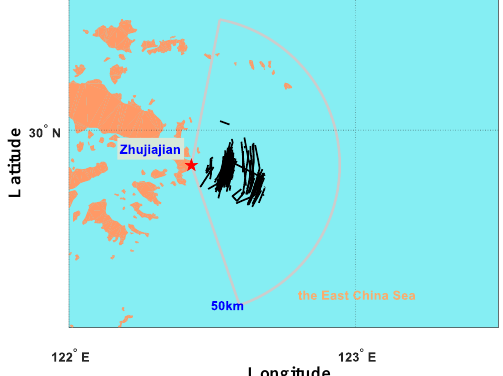
Figure 4. Ships that are used for array phase manifold measurement at 19.1 MHz. Black lines in the map denote the AIS-ship